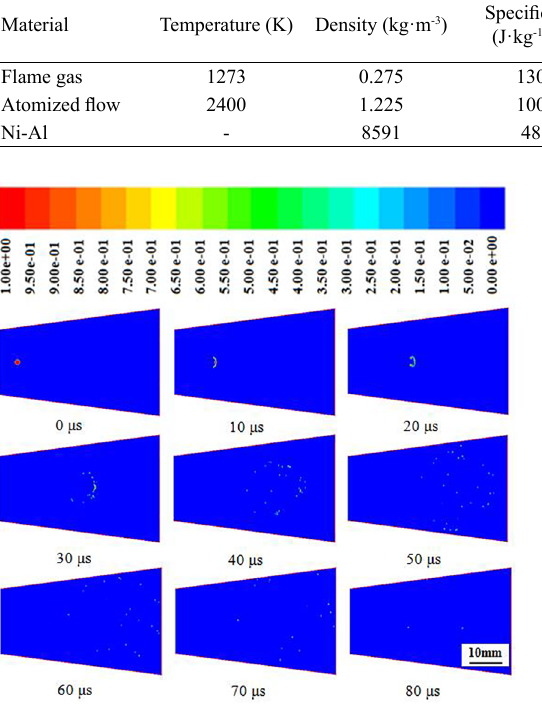
Figure 3. Time dependence of TWAS atomized droplet breakup process